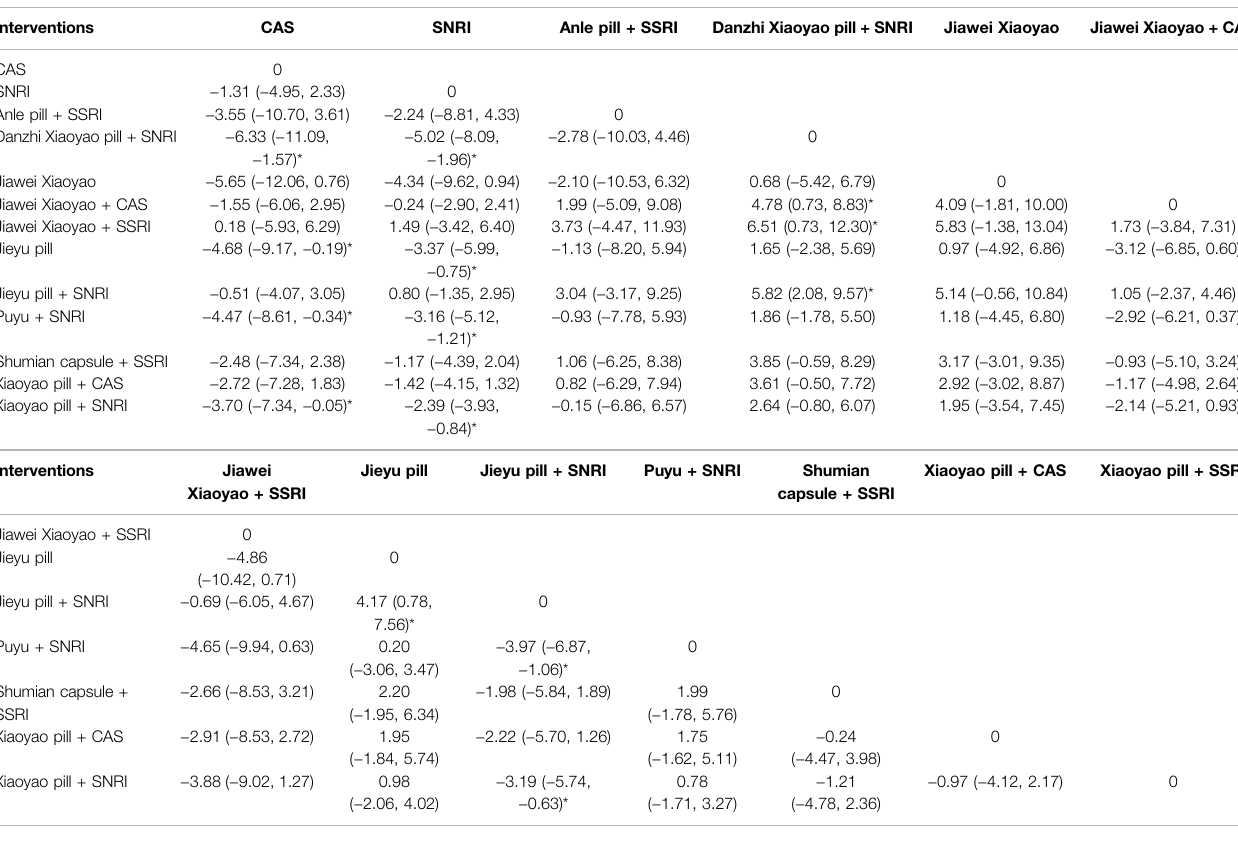
TABLE 6 | Network meta-analysis of adverse reactions RR